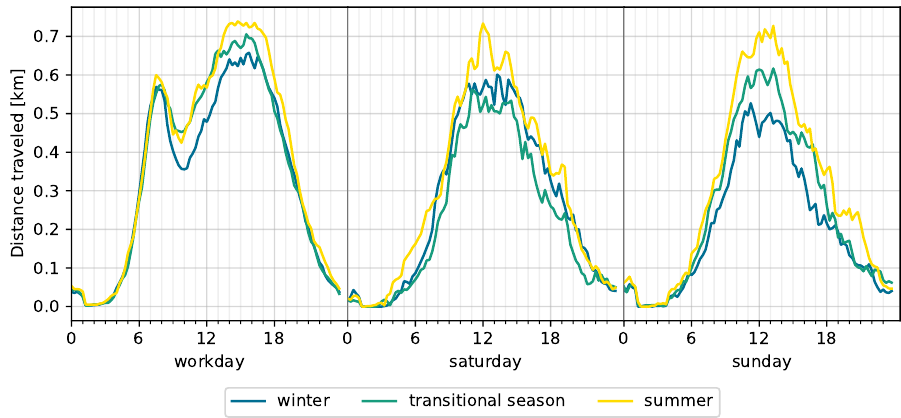
Figure 3. Average distance driven according to the driving profiles, based on [13].